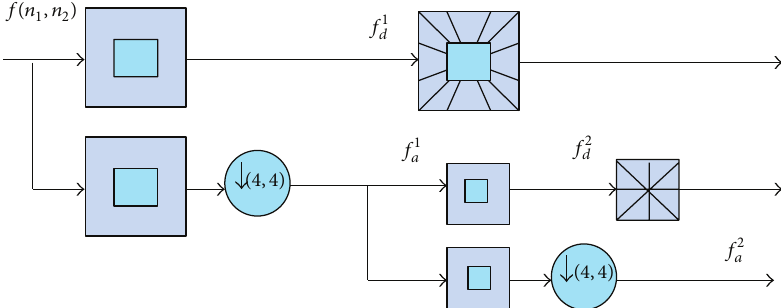
Figure 4: Succession of Laplacian pyramid and directional